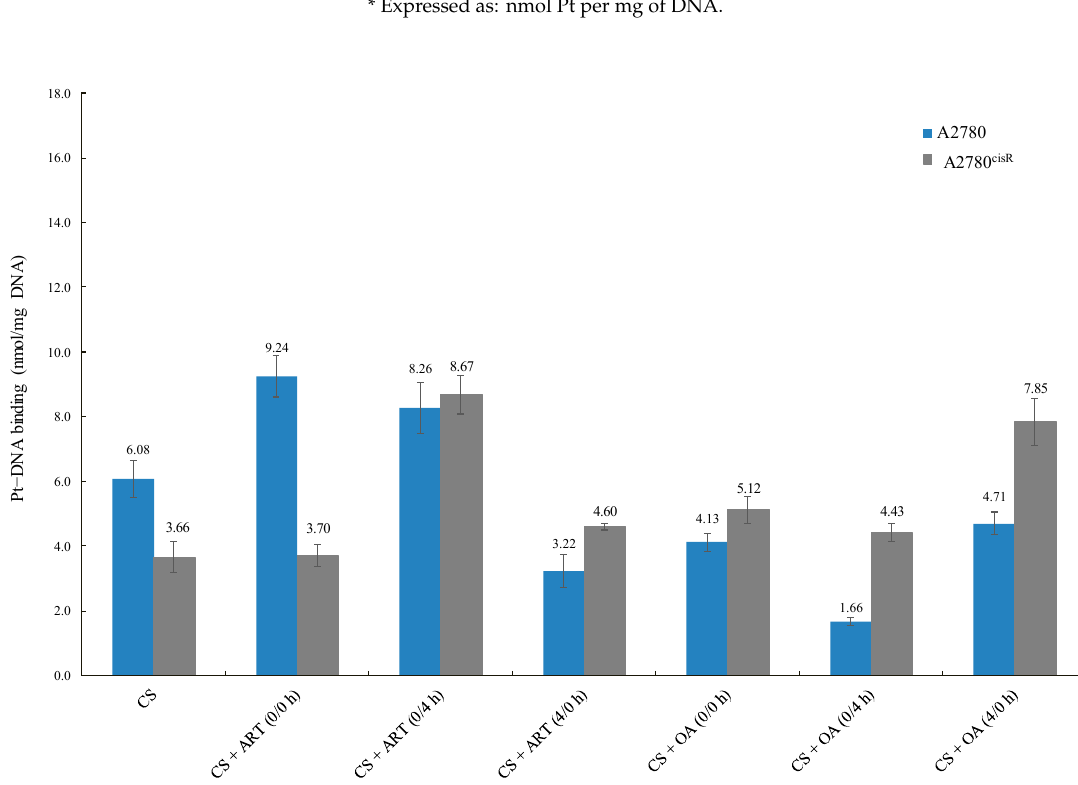
Figure 4. Platinum–DNA-binding levels of CS alone and in combinations with ART and OA.